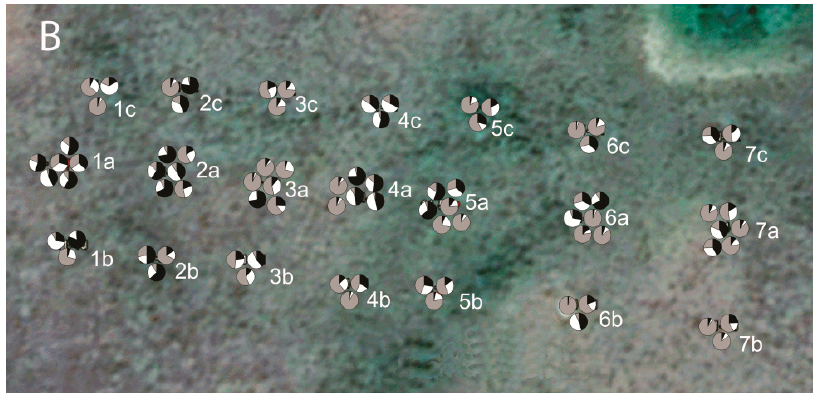
Figure 7. Spatial distribution map of sampled Scots pine ( Pinus sylvestris L.) juveniles regenerating on abandoned agricultural land (see Figure 1 for more information). Circles show STRUCTURE groups of individual juveniles as assigned to two ( A ) and three ( B ) most likely genetic clusters.